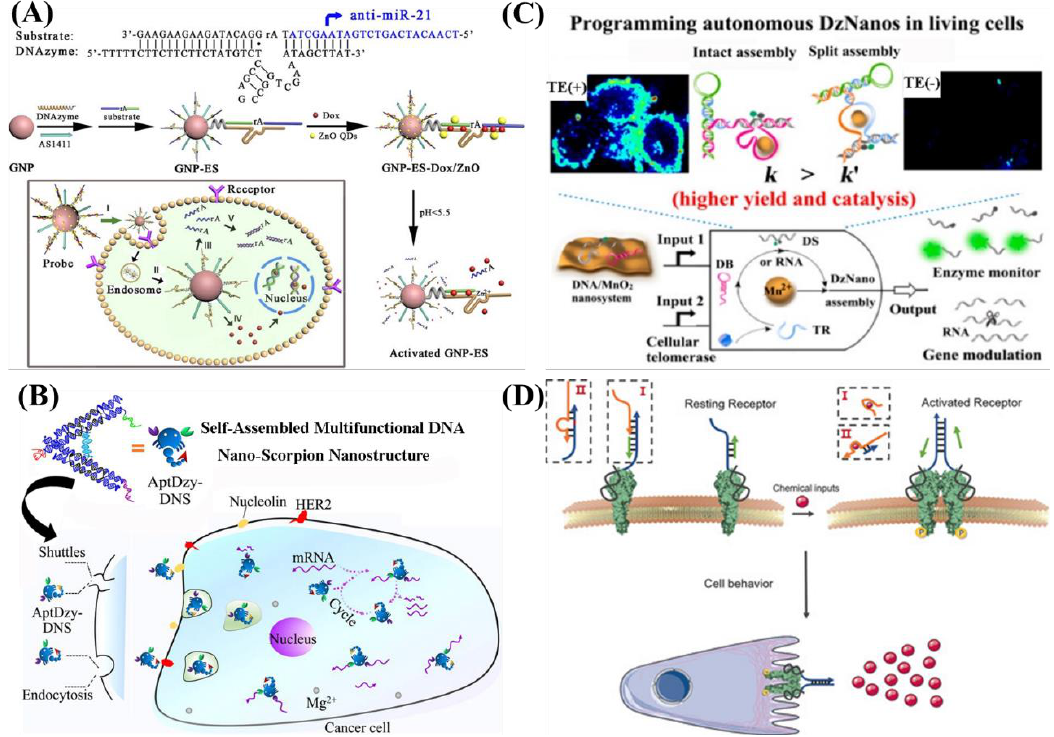
Figure 7. Representative examples for intracellular gene regulation and other applications based on RNA-cleaving DNAzymes. ( A ) A schematic illustration of the DNAzyme–gold nanoprobe for controlled Dox release and gene regulation in living cells. GNP = gold nanoparticle, ES = DNAzyme and its substrate. Reprinted with permission from reference [73]. Copyright 2016 Nature Publishing